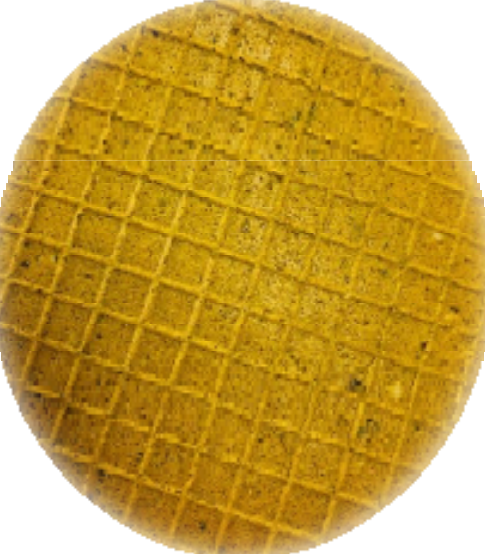
Figure 4. Spent grain wafers.